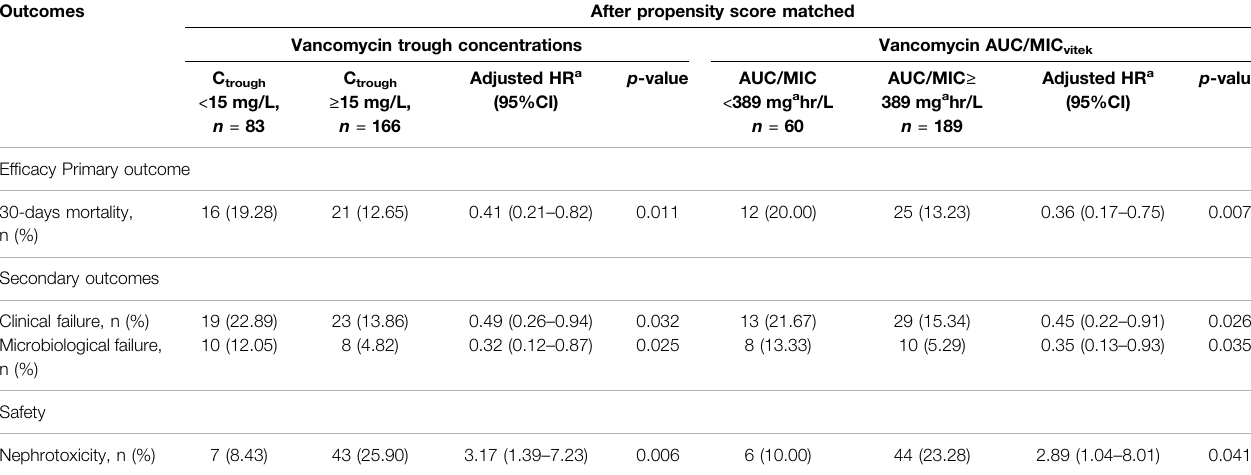
TABLE 3 | Analysis of primary and secondary outcomes for enterococcal infection patients with vancomycin trough concentration ≥ 15 mg/L and AUC/MIC ≥ 389 mg a hr/L. Outcomes